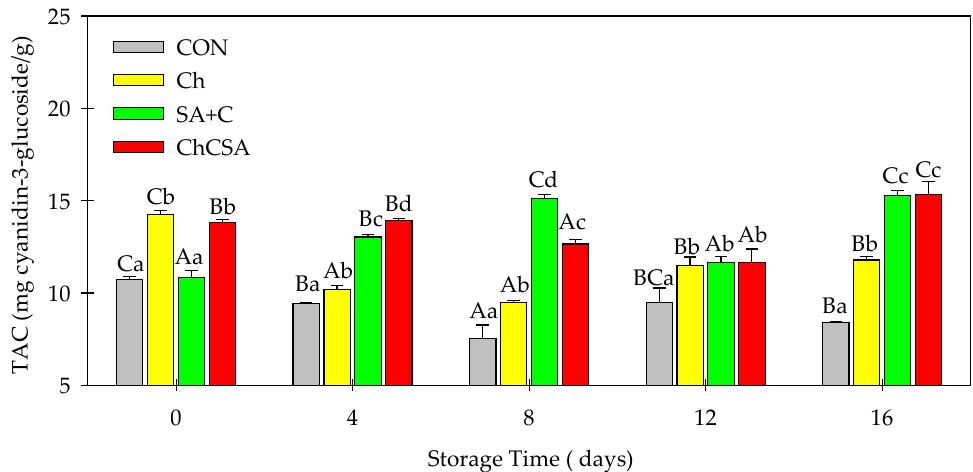
Figure 9. The effect of single-layer and gel coatings on the anthocyanin content on fresh-cut purple sweet potatoes. Vertical bars represent means and standard deviation. Bars with different alphabets within the same storage day (lower case) or same treatment group at different storage days (upper case) are significantly different (Tukey’s HSD Test, p ≤ 0.05).